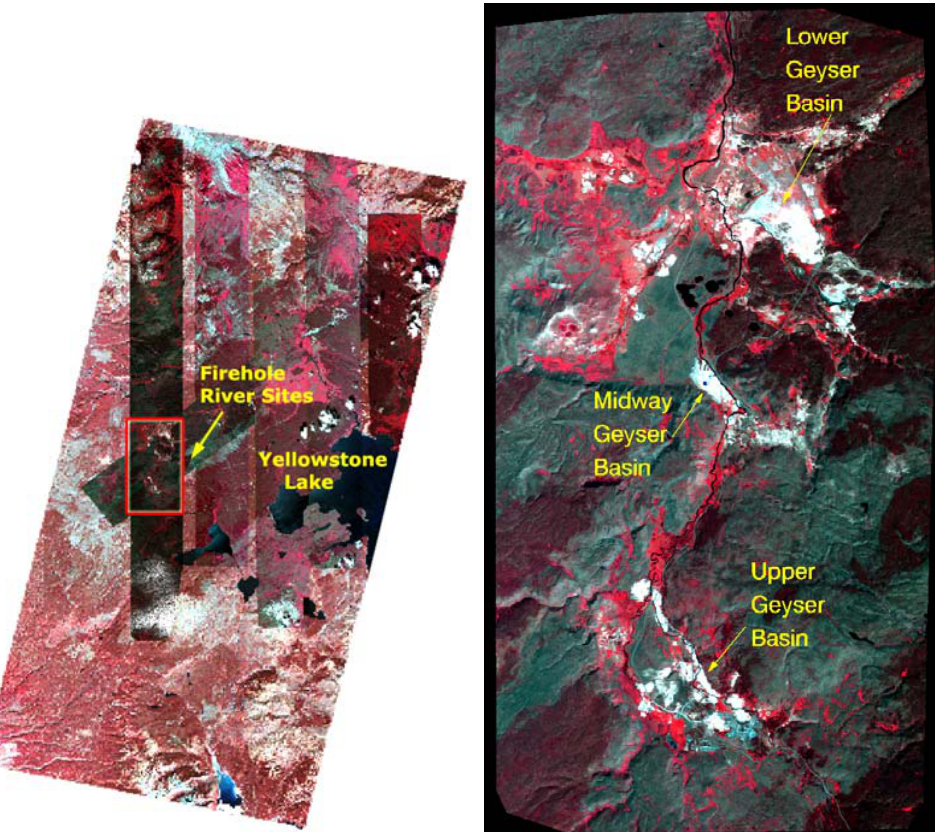
Figure 5. Left: False color composite (color infrared or CIR) image of a portion of Yellowstone National Park. Yellowstone Lake can be used for location purposes. The large image base is two orthorectified ASTER images at 15 m spatial resolution. The ASTER image base is approximately 60 km. Also shown are 6 AVIRIS flightlines from 1997 orthorectified and overlain on the ASTER data for flightline location purposes. The Firehole River area 1996 AVIRIS subset described in the following sections (which fell along the same flightlines as the 1997 data) is outlined and labeled. Right: False color composite (color infrared or CIR) 1996 AVIRIS image of the Firehole River area. Each AVIRIS Image base in the left mosaic and the AVIRIS image base in the right image is approximately 10 km. North is to the